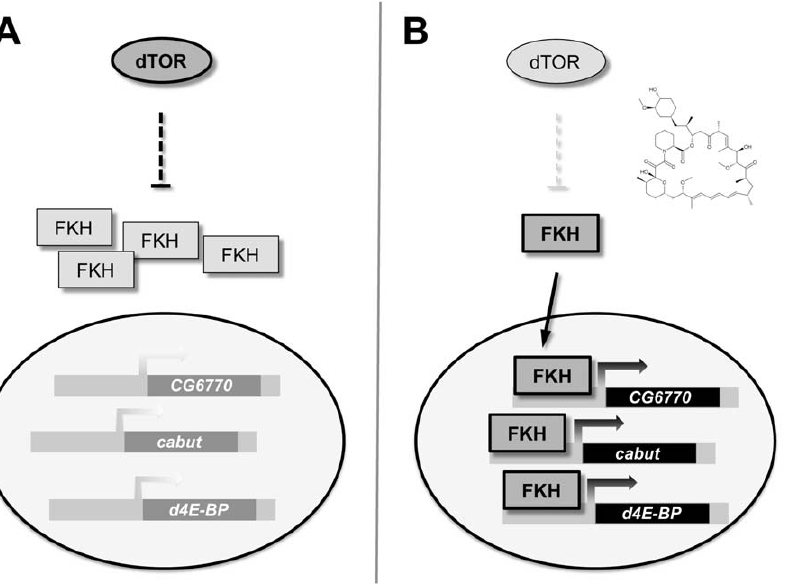
Figure 8. A simplified working model of nutrient-dependent gene expression by TOR and FKH. ( A ) Under conditions of dietary protein abundance, the TOR signaling module is active and exerts a negative regulation on FKH, which is consequently sequestered in the cytoplasm and unable to modulate gene transcription. ( B ) When TOR complex 1 activity is inhibited by rapamycin or protein deprivation, the repression of FKH activity is diminished. A significant fraction of the cellular FKH pool accumulates in the nucleus and activates expression of the growth-inhibiting genes CG6770 , cabut and d4E-BP .